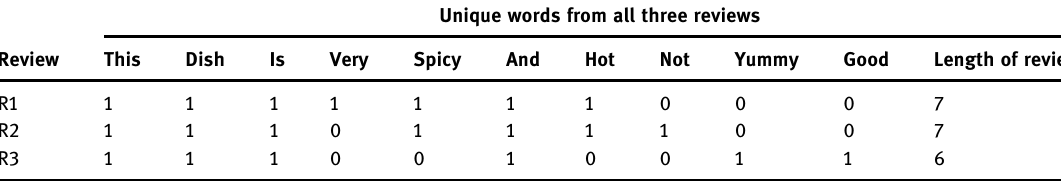
Unique words from all three